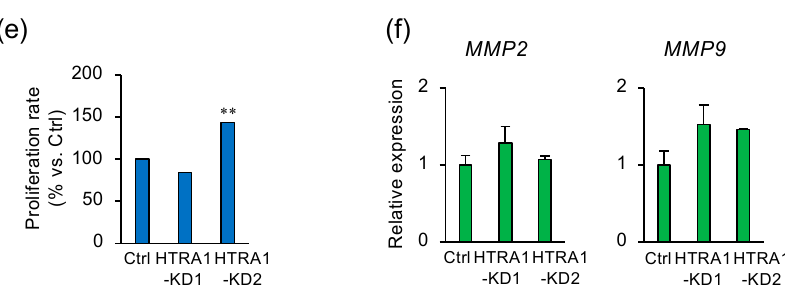
Figure 2. HTRA1 regulates invasion by extravillous trophoblast cells. ( a ) Tissue sections of human placenta were stained with anti-HTRA1, HLA-G (positive control for extravillous trophoblast), or normal rabbit IgG (negative control). ( b , c ) Extravillous trophoblast HTR8/SVneo cells were transfected with two different HTRA1 siRNAs (HTRA1-KD1 and -KD2, each 50 nM) and incubated for 24 h. ( b ) The mRNA expression of HTRA s and A1AT was determined ( n = 3). GAPDH was used as the reference gene. The values are the means ± SEMs. ** p < 0.01. ( c ) Lysates prepared from HTR8/SVneo cells that had been transfected with HTRA1-KD1 or -KD2 were subject to immunoblotting. GAPDH served as a loading control. ( d ) HTR8/SVneo cells that had been transfected with HTRA1-KD1 or -KD2 were incubated in Matrigel-coated transwells for 48 h. Representative images of the cells that passed through the transmembranes are shown in panels on the left. The numbers of cells that passed through the transmembranes were counted and are presented as the means ± SEMs of three independent experiments. ** p < 0.01. ( e ) HTR8/SVneo cells that had been transfected with HTRA1-KD1 or -KD2 were cultured for 48 h, and then the numbers of cells were determined using a WST-8 assay. ** p < 0.01. ( f ) The mRNA expression of MMP2 and MMP9 in HTR8/SVneo cells that had been transfected with HTRA1-KD1 or -KD2 was measured. GAPDH was used as the reference gene. The values are the means ± SEMs of the three independent experiments.